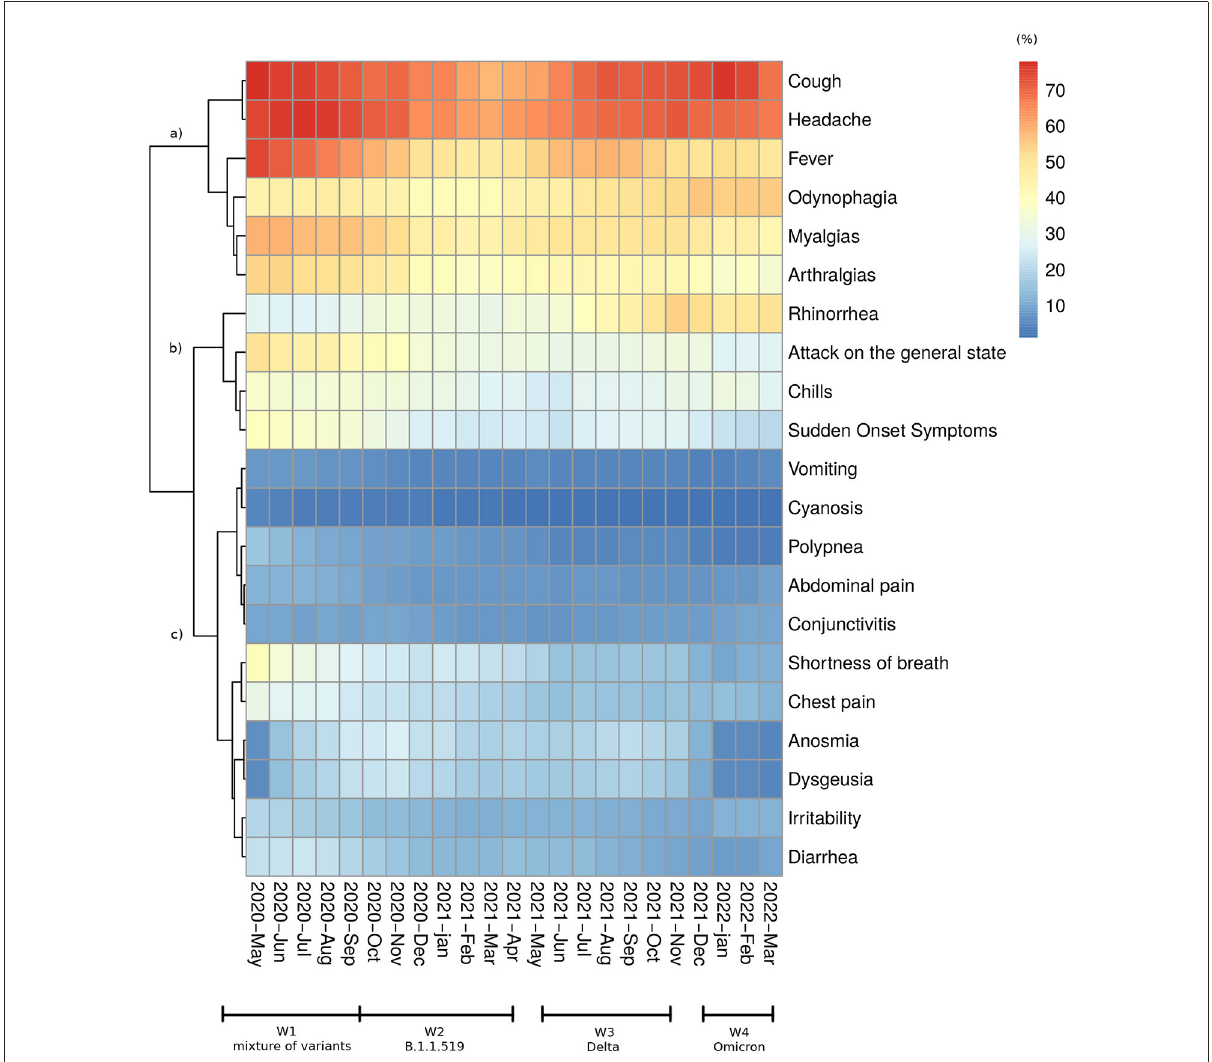
FIGURE3 Symptom distribution. Heatmap and the cluster showing changes in the proportion of each recorded symptom among confirmed patients from May 2020 to March 2022.